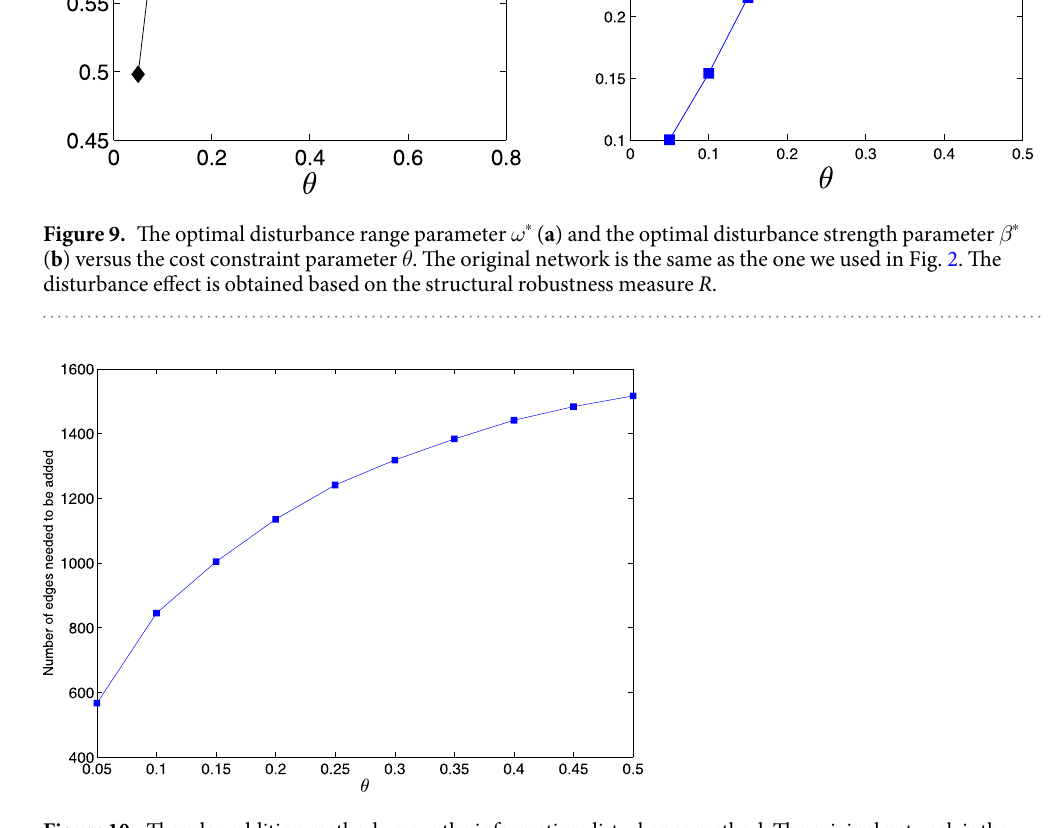
Figure 10. The edge addition method versus the information disturbance method. The original network is the same as the one we used in Fig. 2. The disturbance effect is obtained based on the structural robustness measure R .